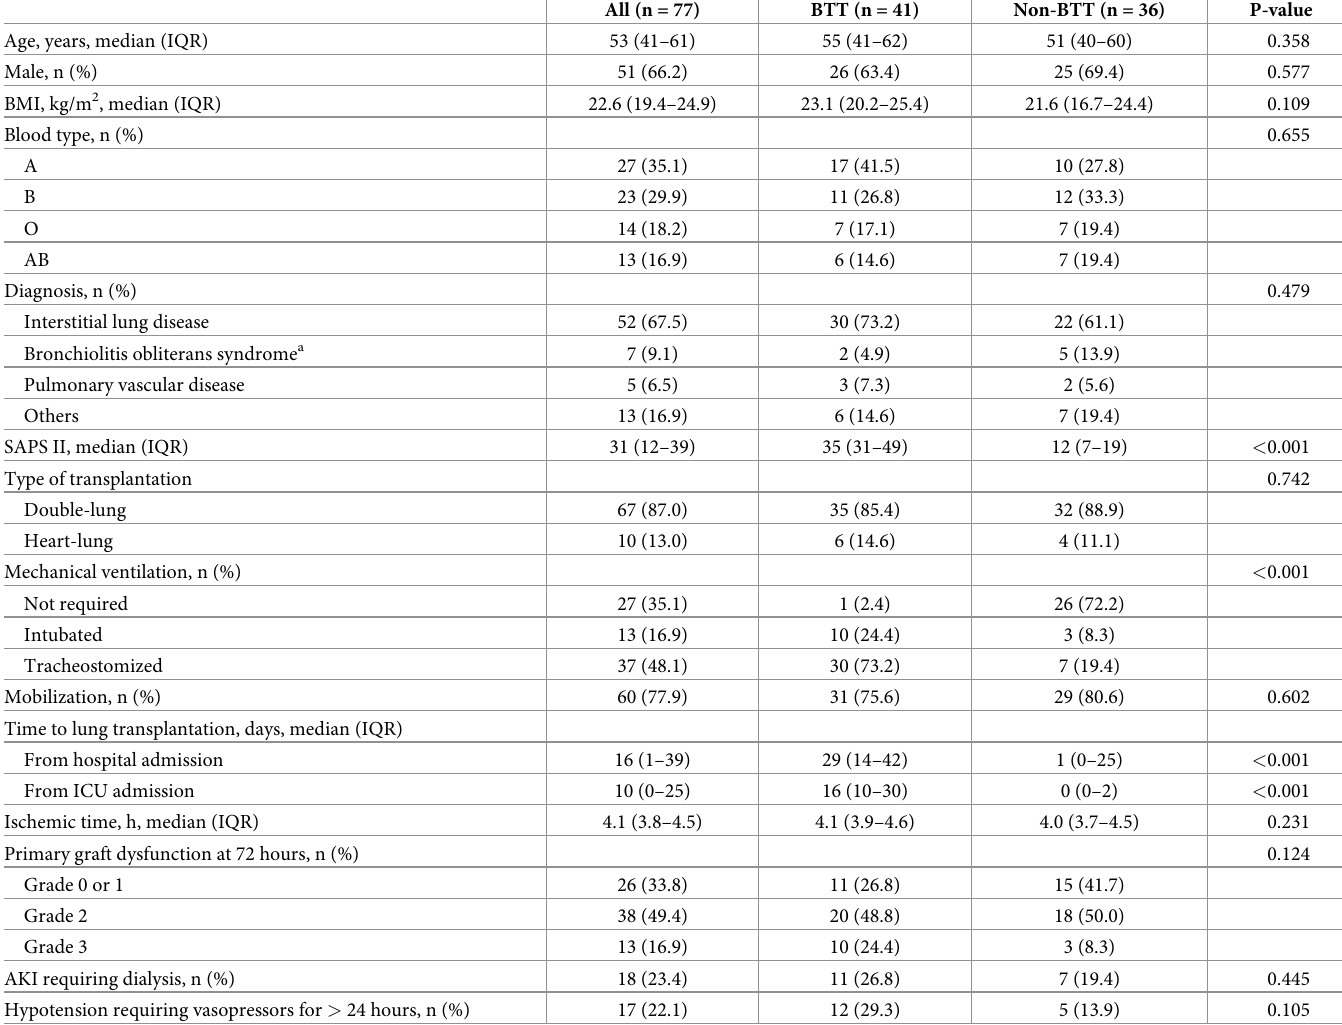
Table 1. Demographic and clinical characteristics of the BTT and the non-BTT groups at the time of transplantation.